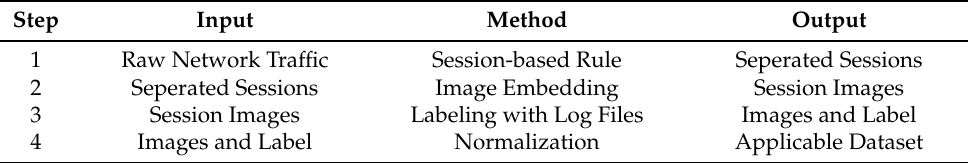
Table 2. The Preprocessing Module at